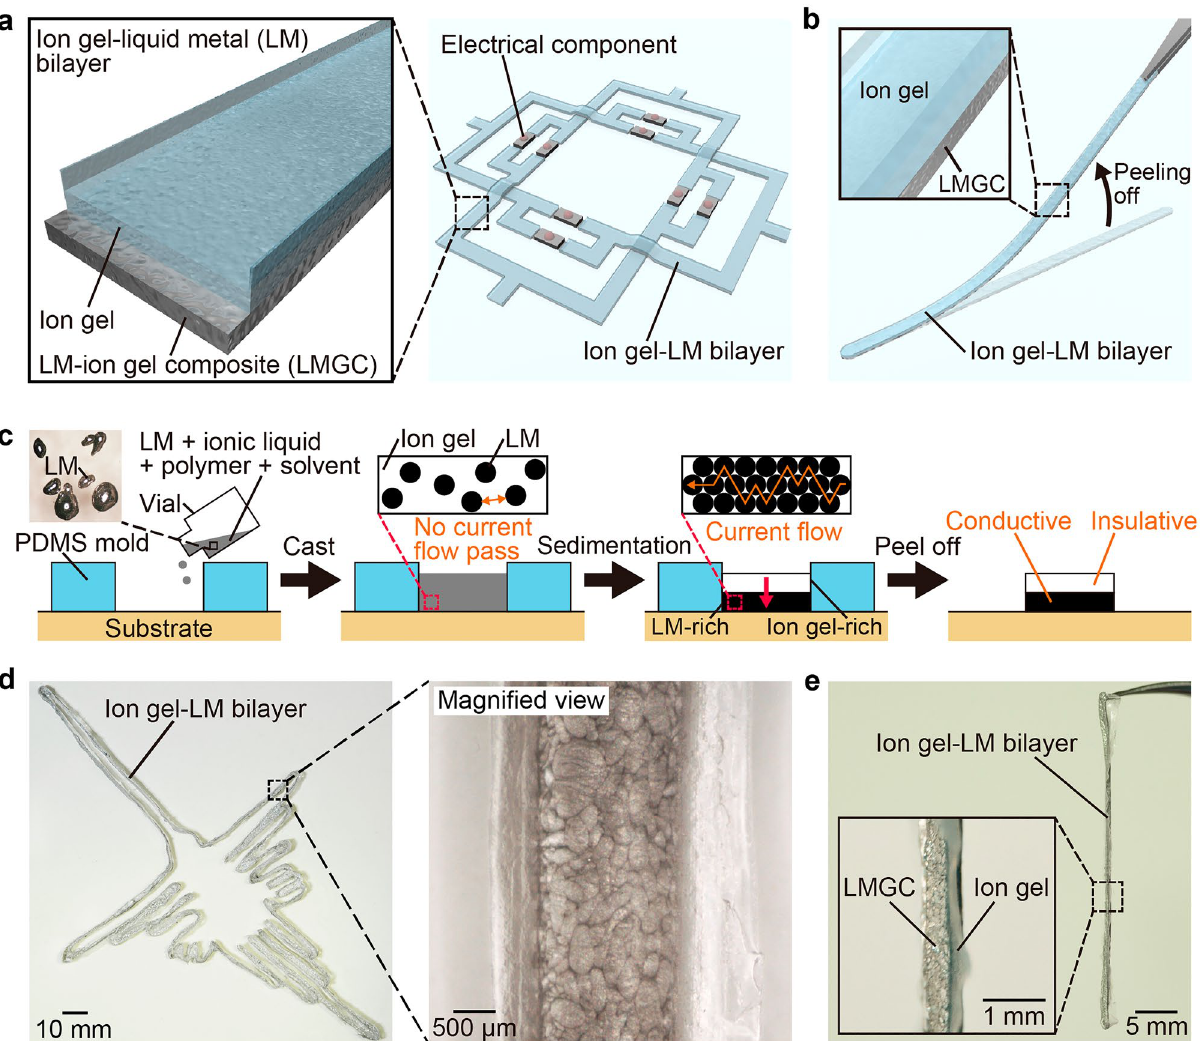
Figure 1. Patterning of the ion gel-liquid metal (LM) bilayer. ( a ) Schematic of the ion gel–LM bilayer. The bilayer structure, consisting of the bottom LM–ion gel composite (LMGC) conductive layer and the top ion gel insulating layer, is self-assembled. ( b ) Schematic of the ion gel–LM bilayer being peeled off with tweezers. ( c ) Fabrication method of the ion gel–LM bilayer. The LM in the solution sediments until the solvent volatilizes, resulting in the self-assembly of the top ion gel-rich layer and the bottom LM-rich layer after the gelation of the ion gel is completed. ( d ) The ion gel–LM bilayer patterned in the desired shape. ( e ) The ion gel–LM bilayer lifted up. The LM was retained without